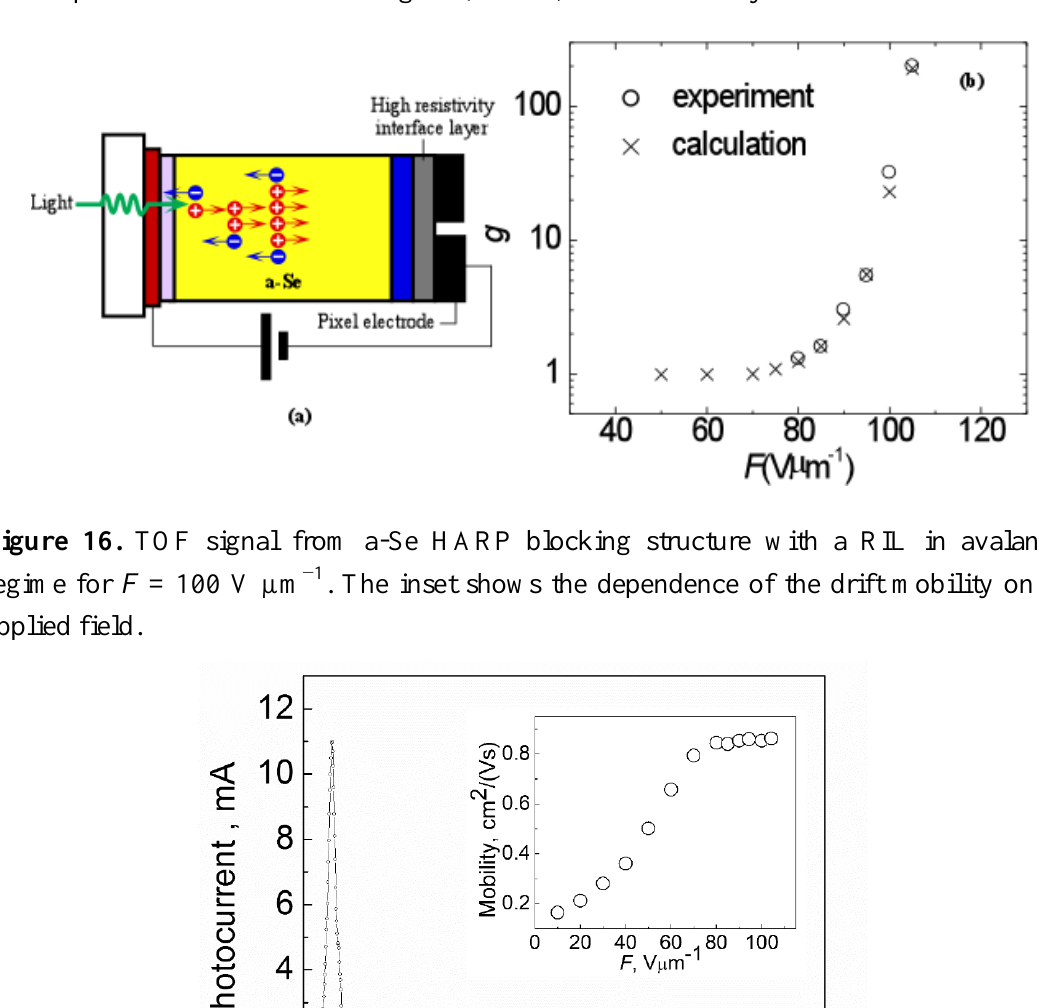
Figure 15. (a) A modified-HARP structure with an RIL (resistive interface layer) and the development of a fully electroded image sensor, which can be used in direct and indirect conversion detectors. (b) Experimentally measured field dependence of avalanche gain for 15  m thick modified-HARP structure (open circles) in comparison with the theoretical field dependence of the avalanche gain (crosses) for the same layer thickness.